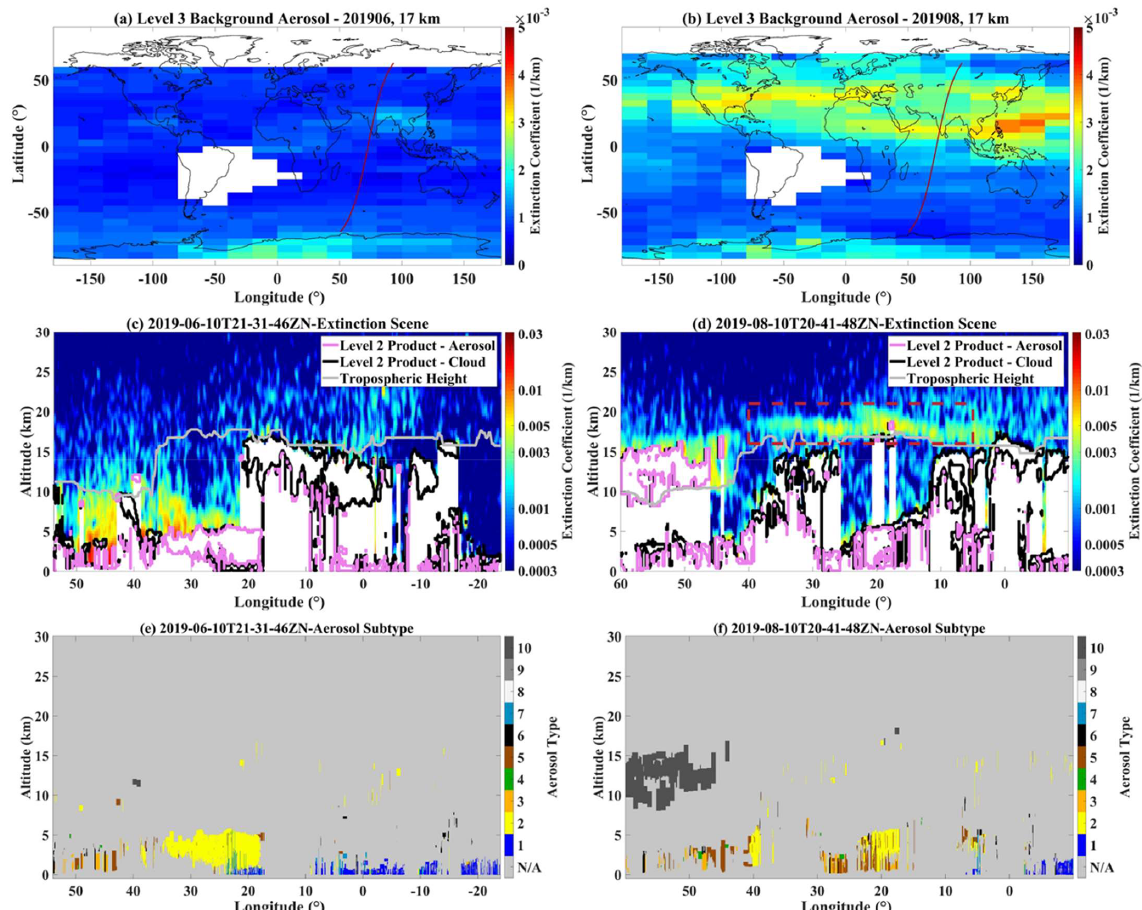
Figure 8. Panels (a) and (b) are the stratospheric extinction distributions of CALIPSO level 3 stratospheric aerosol profile products at 17km in June and August, respectively. Panels (c) and (d) are the retrieved aerosol extinction scenes based on CALIPSO instantaneous data on 10 June and 10 August, respectively, which are consistent with Fig. 4a. The corresponding trajectories for the two scenes are shown as red lines in (a) and (b) , and the corresponding aerosol subtypes are shown in (e) and (f) , which is the as same as in Fig.